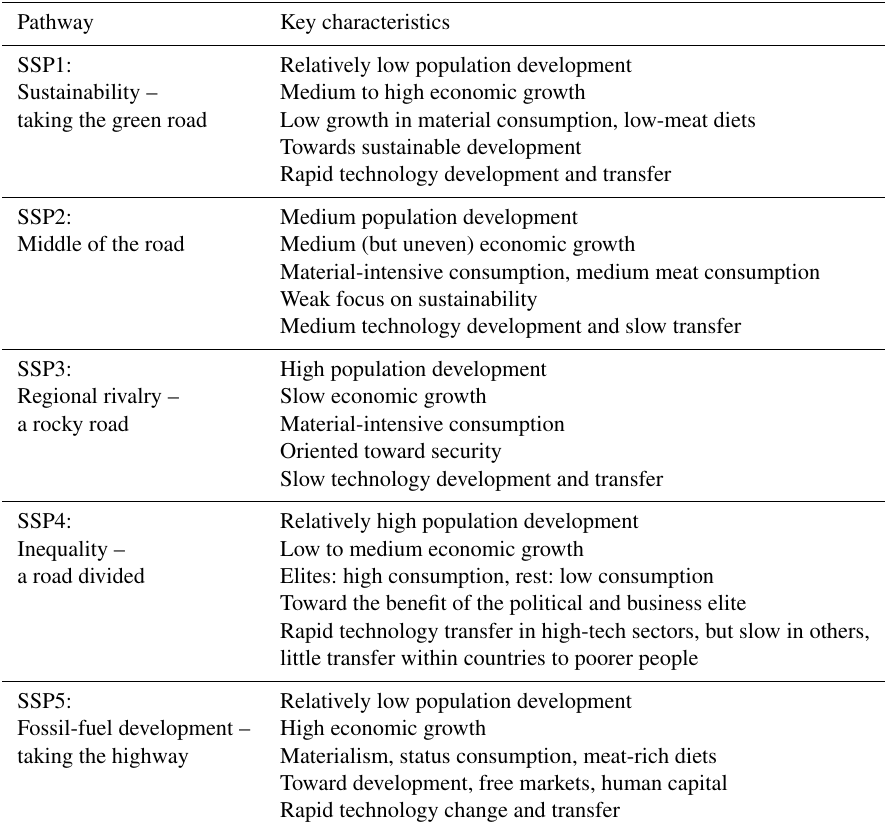
Table 3. Summary of the shared socio-economic pathway key characteristics (population development, economic growth, consumption and diet, policy orientation, and technological change) based on Engström et al. (2016) and O’Neill et al. (2017). Pathway Key